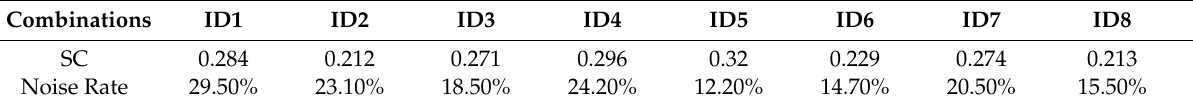
Table 3. SC and noise rate of parameter combinations.